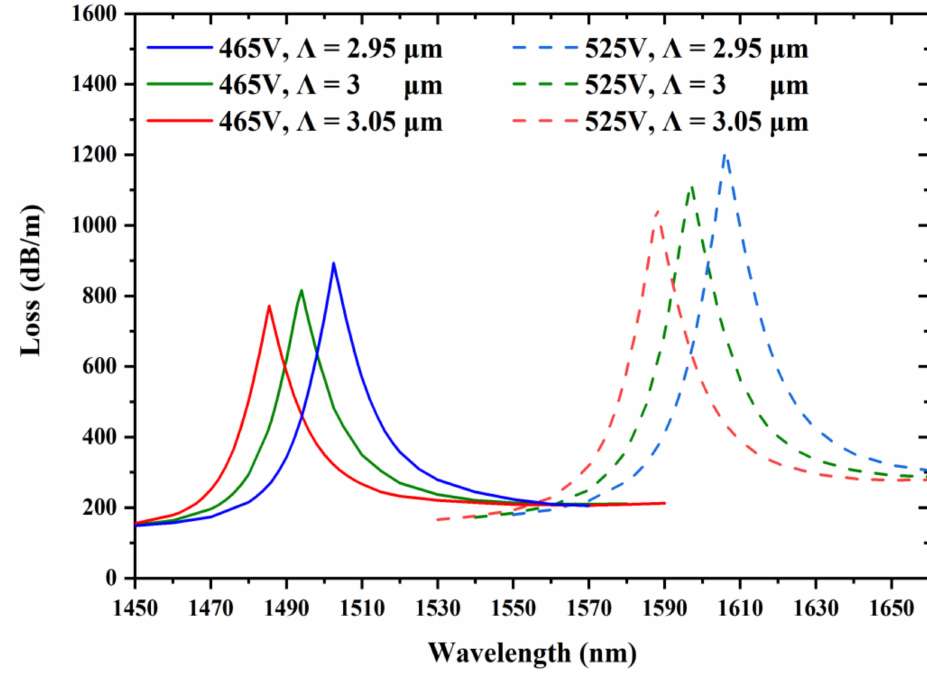
Figure 9. Variation in the confinement loss at the voltages of 465 and 525 V by varying the spacing of the triangular-lattice distribution Λ = 2.95, 3, and 3.05 µ m, while other structural parameters are d = 1.4 µ m, d 1 = 1.4 µ m, and d 2 = 2.1 µ